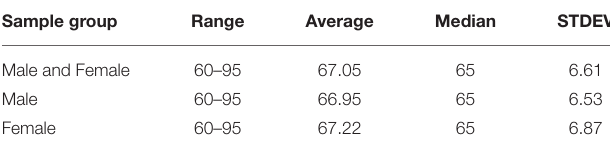
TABLE 1 | Description of the